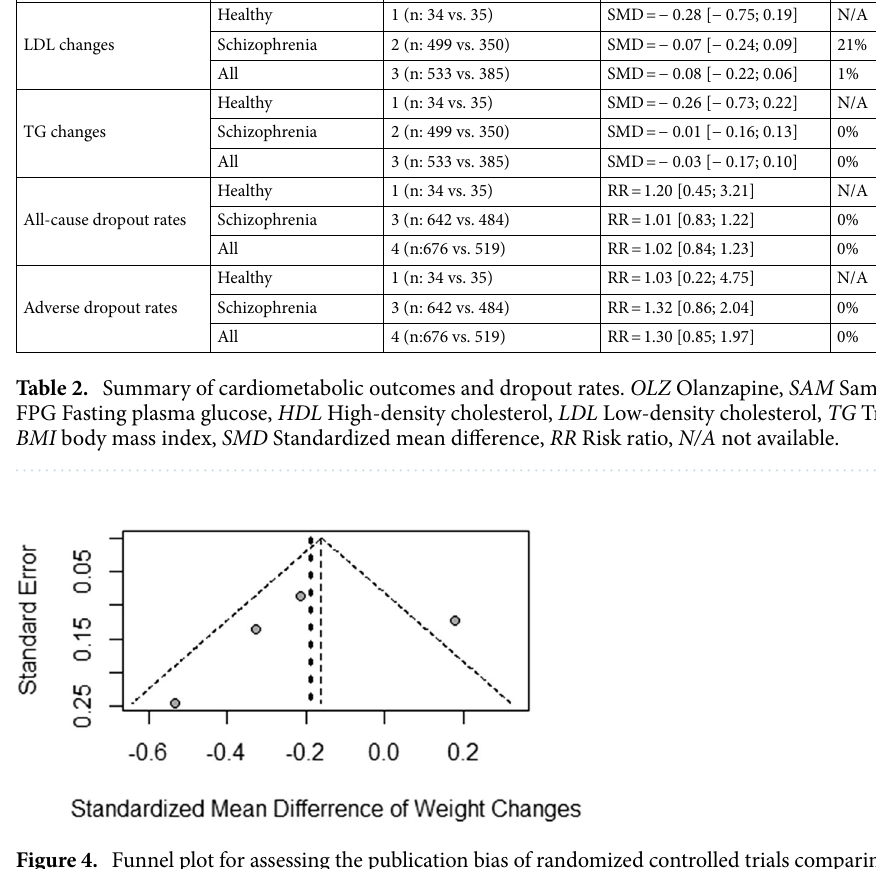
Figure 4. Funnel plot for assessing the publication bias of randomized controlled trials comparing olanzapine/ samidorphan and olanzapine for mitigating olanzapine-induced weight gain. The bold dash line indicates the random effects